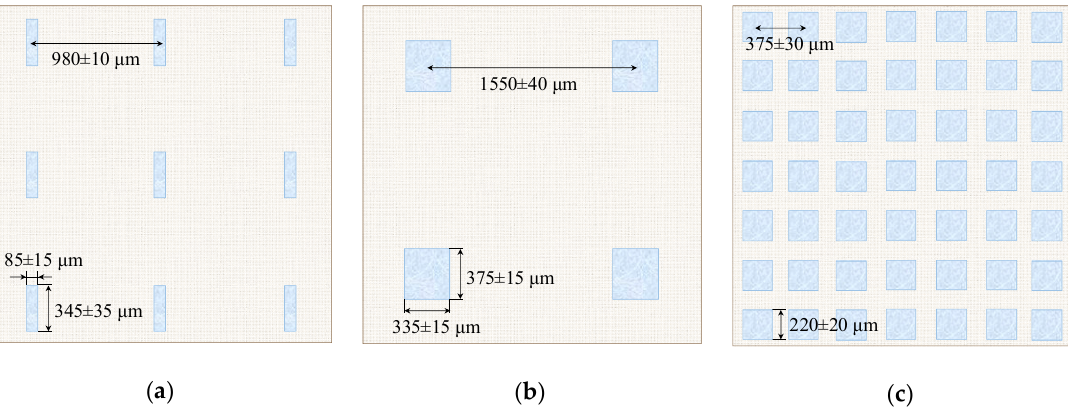
Figure 11. Schematic view of the surface of the AMX-Sb 1 ( a ), AMX-Sb 2 ( b ), and AMX-Sb 5 ( c ) membranes. The same scale is used for all membranes.